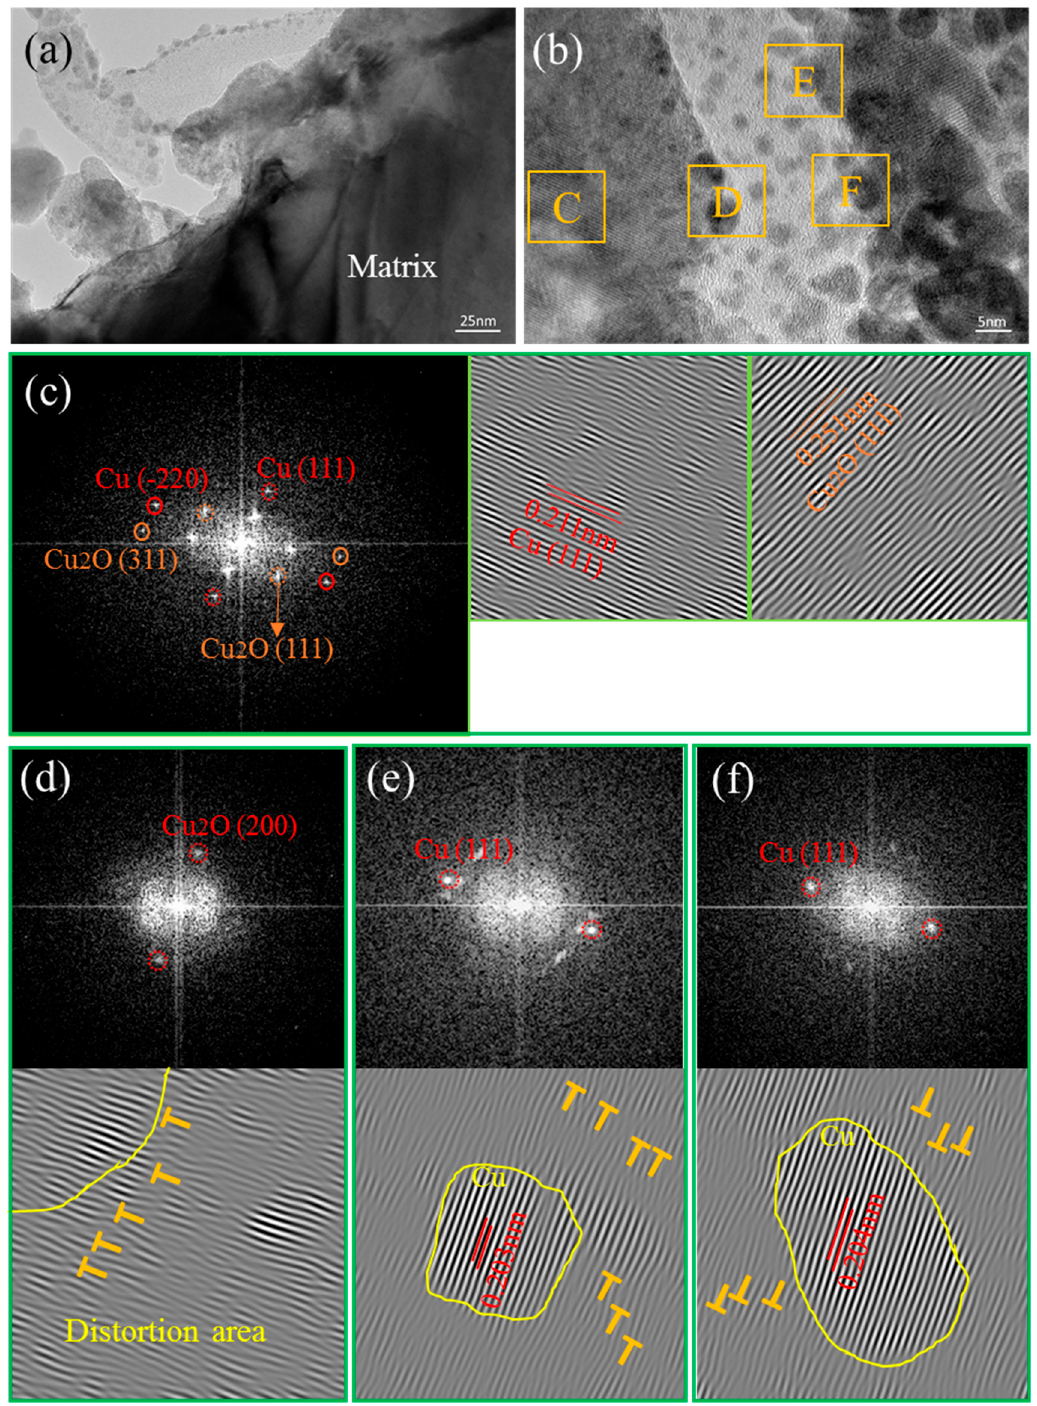
Figure 9. ( a , b ) TEM image of SP-0.3 wt % CNT-Cu composite; ( c – f ) FFT and IFFT of regions C, D, E, Figure 9. ( a ), ( b ) TEM image of SP-0.3 wt % CNT-Cu composite; ( c ), ( d ), ( e ), ( f ) FFT and IFFT of regions and F, C, D, E, and F, respectively.